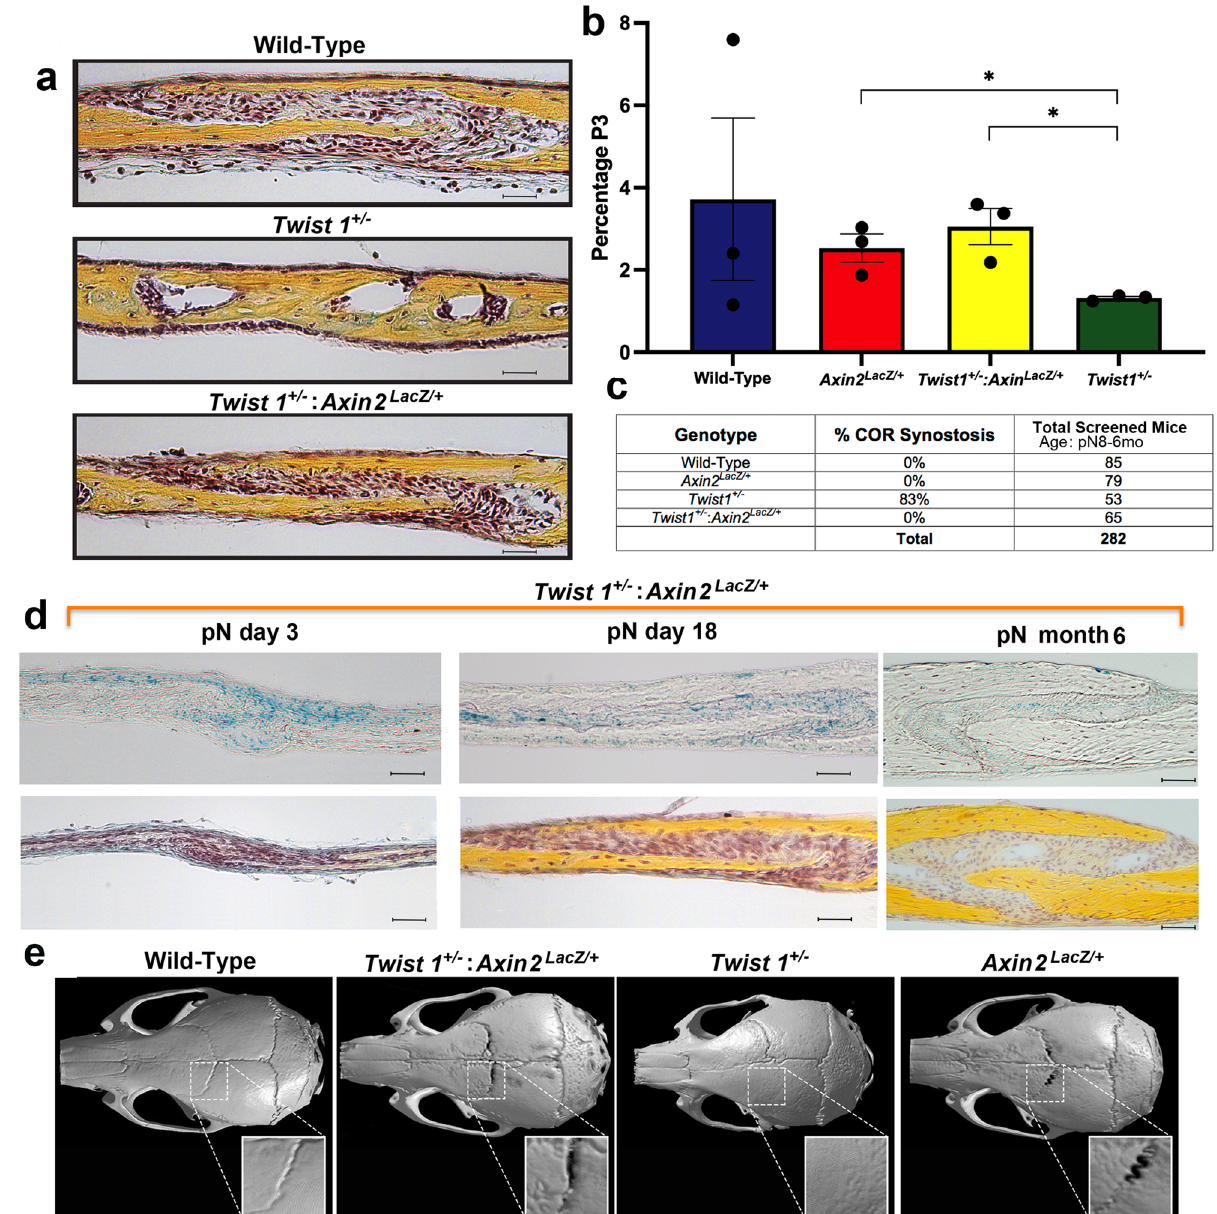
Fig. 5 Sustained activation of cWnt signaling rescues COR suture craniosynostosis in Twist1 + / − mice. a Pentachrome staining and histological analysis of pN15 COR sutures from wild-type (top panel), Twist1 + / − (middle panel) and Twist1 + / − :Axin2 LacZ/ + (bottom panel) mice. Similar to the wild-type suture, the Twist1 + / − :Axin2 LacZ/ + COR suture is patent with a clear undifferentiated tissue mesenchyme between the osteogenic fronts, thus demonstrating a rescue of the COR suture craniosynostosis. Conversely, the Twist1 + / − COR suture is fused, showing a bony bridge and lack of a suture mesenchyme. Scale bars, 100 μ m. Magni fi cation at ×20. n = 3 animals/group, experiments were repeated 3 independent times. b FACS analysis of CD51 + ;CD200 + cells isolated from COR sutures of wild-type, Axin2 LacZ/ + , Twist1 + / − , and Twist1 + / − :Axin2 LacZ/ + mice indicates increased representation of CD51 + ;CD200 + cells in the Twist1 + / − :Axin2 LacZ/ + double transgenic. Values represent mean ± SEM; Axin2 LacZ/ + vs. Twist1 + / − P = 0.025, Twist1 + / − vs. Twist1 + / − : Axin2 LacZ/ + , P = 0.0172; * P ≤ 0.05, unpaired, two-tailed student t -test were performed. n = 10 animals/group, experiments were repeated 3 independent times. c Screening for coronal suture fusion in Twist1 + / − versus Twist1 + / − :Axin2 LacZ/ + mice reveals a frequency of COR craniosynostosis in Twist1 + / − : Axin2 LacZ/ + mice restored to that of wild-type mice (i.e., patent COR suture phenotype), compared to the widespread fusion seen in Twist1 + / − . Screening was performed on mice ranging from day pN6 up to 6 months. n = 282 animals screened. d (top panel) X-gal staining identi fi es a of cWnt-activated cells within the mesenchyme of the patent COR suture in Twist1 + / − : Axin2 LacZ/ + double transgenic mice at day pN3, pN18, and 6 months postnatal. (bottom panel) Movat ’ s pentachrome staining performed on adjacent slide sections as for top panels. Scale bars: 100 μ m. Magni fi cation at ×20. n = 3 animals/ group, experiments were repeated 3 independent times. pN post-natal. e Micro-CT analysis of wild-type, Twist1 + / − :Axin2 LacZ/ + , Twist1 + / − , and Axin2 LacZ/ + skulls at 6 months postnatal reveals the presence of a wide patent COR suture in the Twist1 + / − :Axin2 LacZ/ + mouse, whereas a unilateral fused COR suture is observed in the Twist1 + / − mouse. n = 3 animals/group, experiments were repeated 3 independent times. COR coronal. Source data are provided as a Source data fi le.